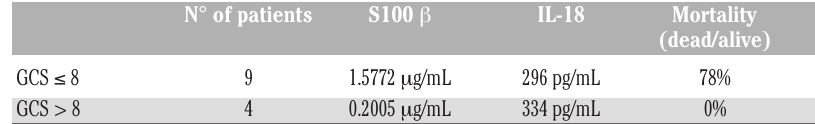
Table 5. Biomarkers in the two GCS-related